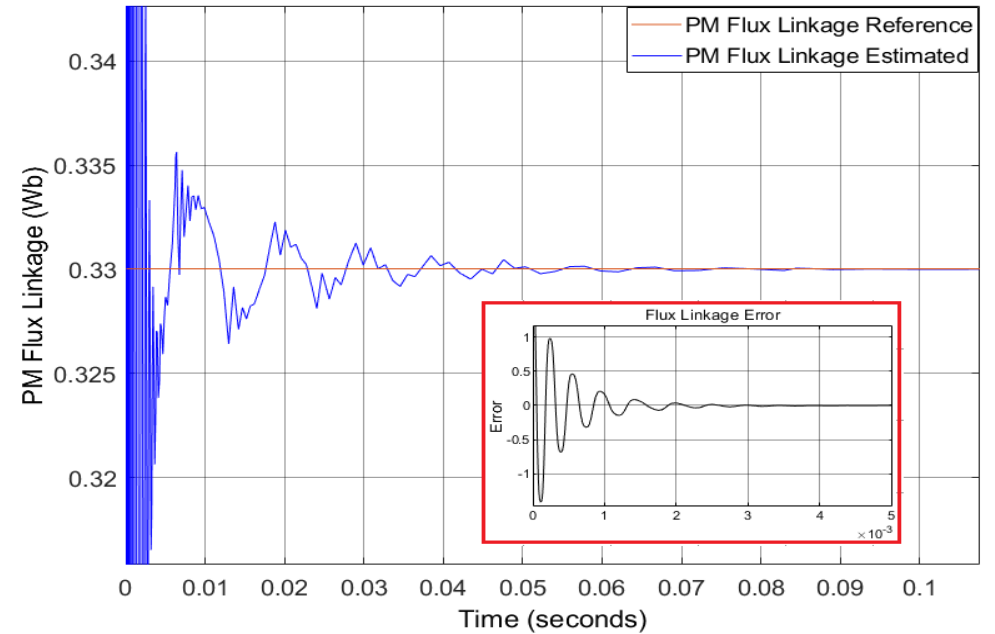
Figure 9. Estimates PM flux linkage in Wb against the reference at a nominal temperature of 20 ◦